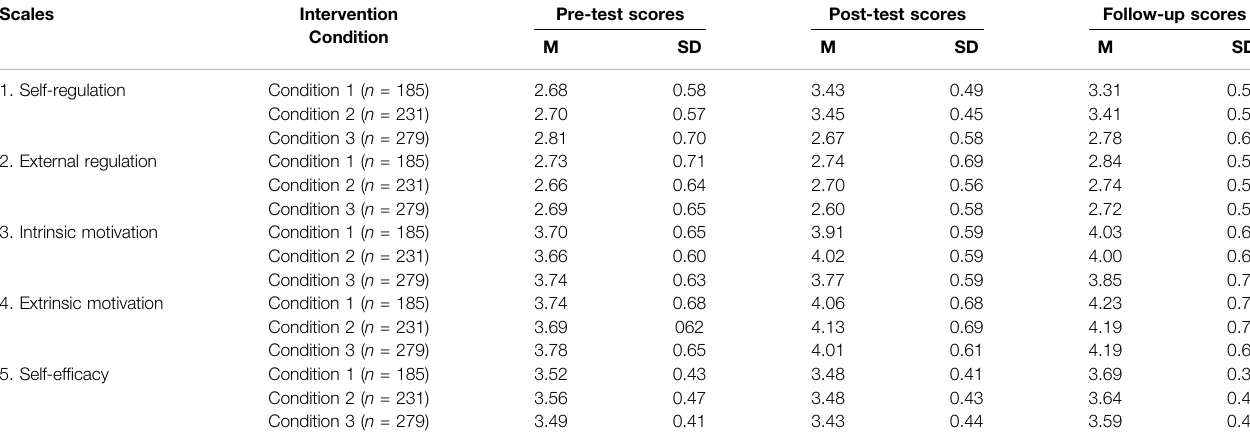
TABLE 5 | Results (mean and SD) of the ILS questionnaire and STPQ questionnaire at pretest, posttest, and follow-up. Scales